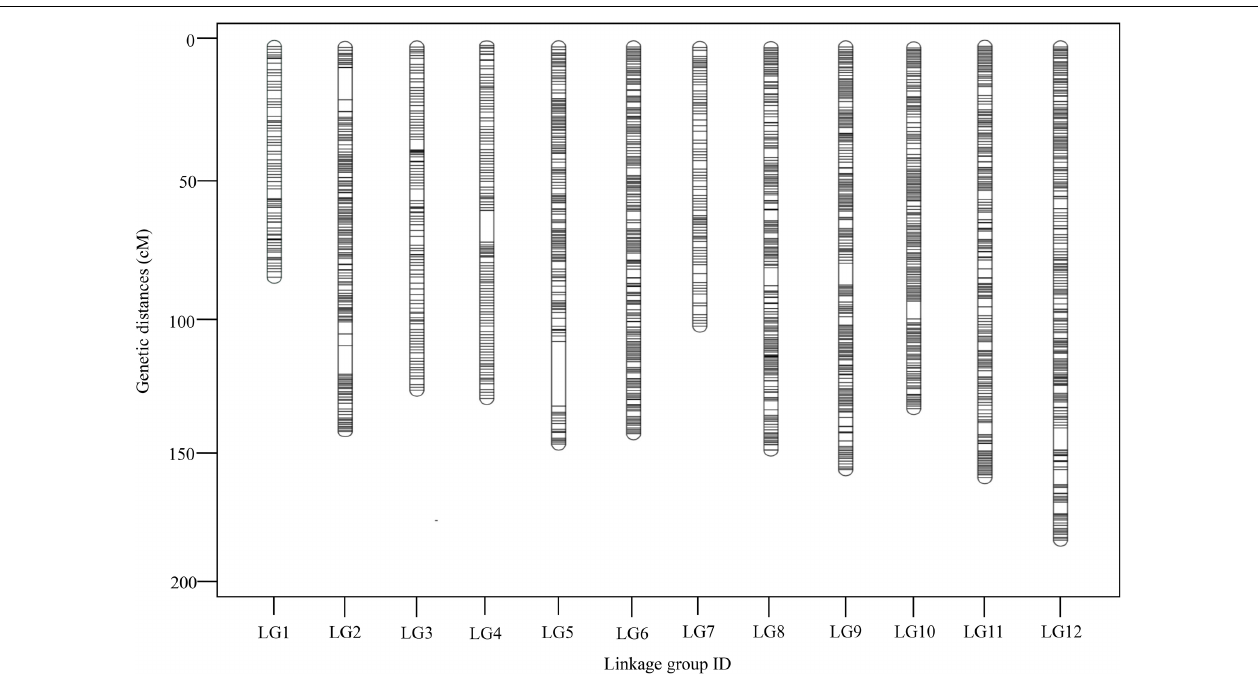
FIGURE 2 | Distribution of SLAFs along each of the linkage group of G. biloba . A black line indicates a SLAF marker.